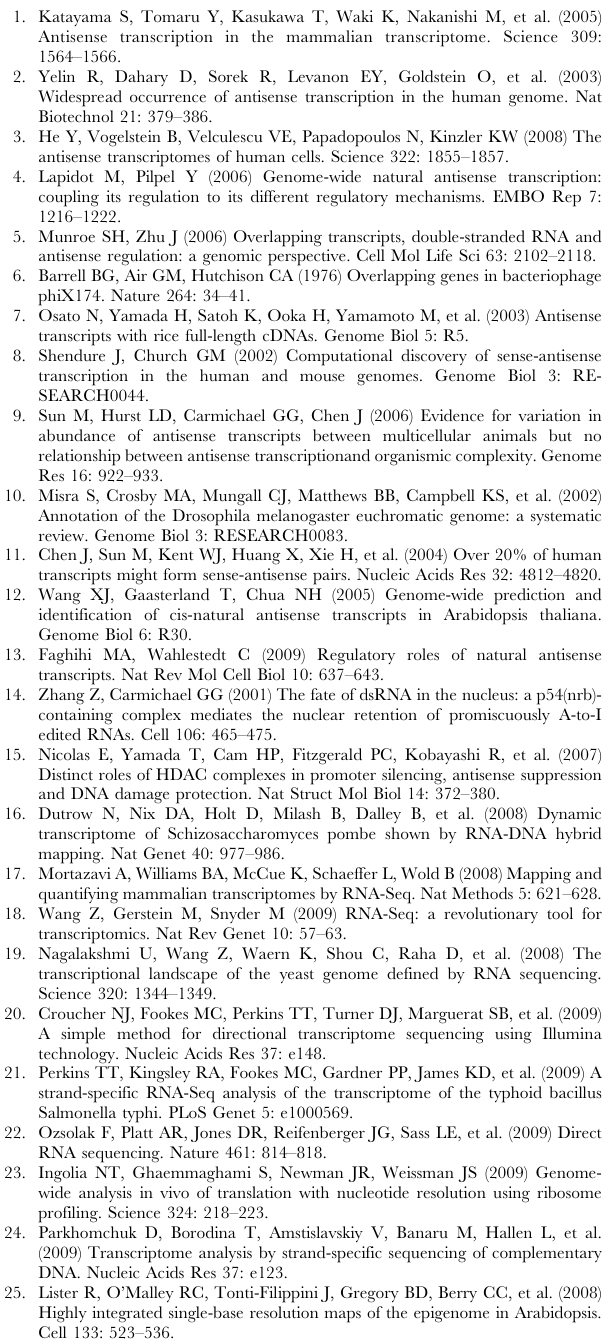
Table S5 GO analysis of genes with AS $ S in NM but not HS condition. Table S6 Primers used for strand-specific RT-PCR and